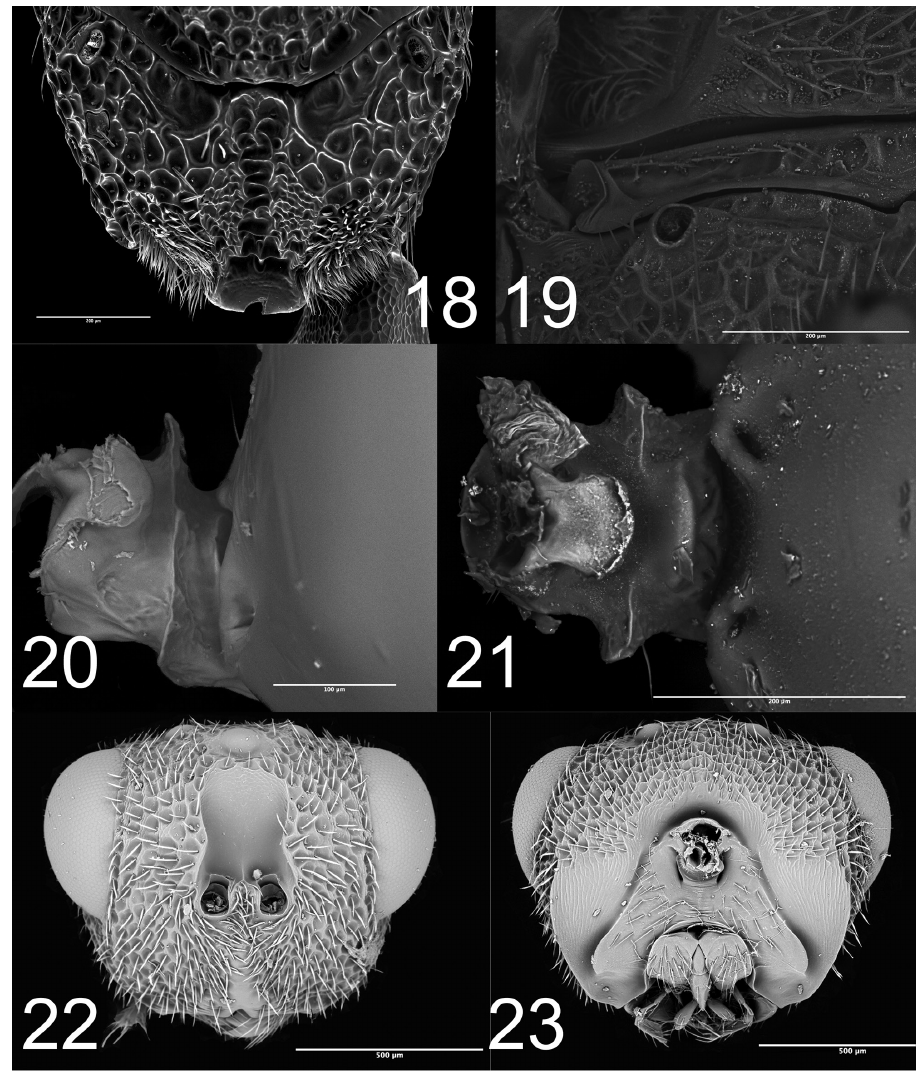
Figures 18–23. Eurytoma obtusilobae 18 Propodeum 20 Petiole, lateral view. E. shorthousei sp. n. 19 Propodeal spiracle 21 Petiole, dorsal view. E. discordans : 22 Head, anterior view 23 Head, posterior view. cynips gall on Quercus obtusiloba [now stellata ; post oak]” from Jacksonville, Florida. The only specimen remaining from this series is a female designated and labeled as a lectotype by Bugbee (1967). Bugbee (1951b) had previously redescribed “ obtusilobae ” based on the types and included 5 females and 10 males collected by J. C. Bridwell in Vienna, Virginia 1941 (ex Rhodites radicum on Rosa palustris ), but the latter belong to E. shorthousei . Only 4 pointed females and males could be located, though there is a gelatin capsule with 30 individuals from the same collecting event were not